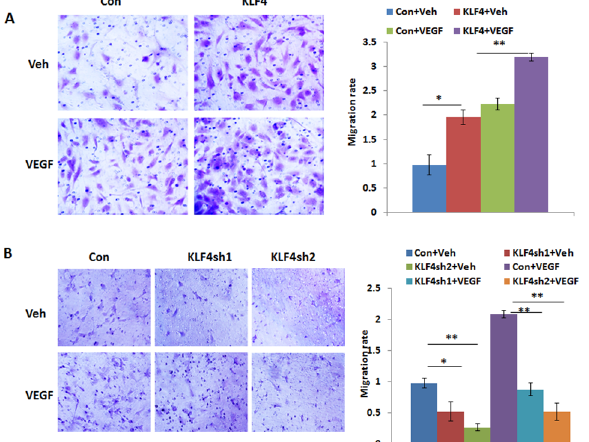
Fig 2. KLF4 promotes VEGF induced cell migration. A, B. Transwell migration assays were performed in HRMECs following KLF4 expression or knockdown. Migrated cells were stained with Crystal Violet and then counted. KLF4 expression in HRMECs significantly increased cell migration while knockdown of KLF4 reduced it as compared to control cells with and without VEGF treatment. The data were presented from three independent experiments in triplicate as mean+S.E and normalized by comparing it to vehicle treated control cells ( * p < 0.05, ** p < 0.01).